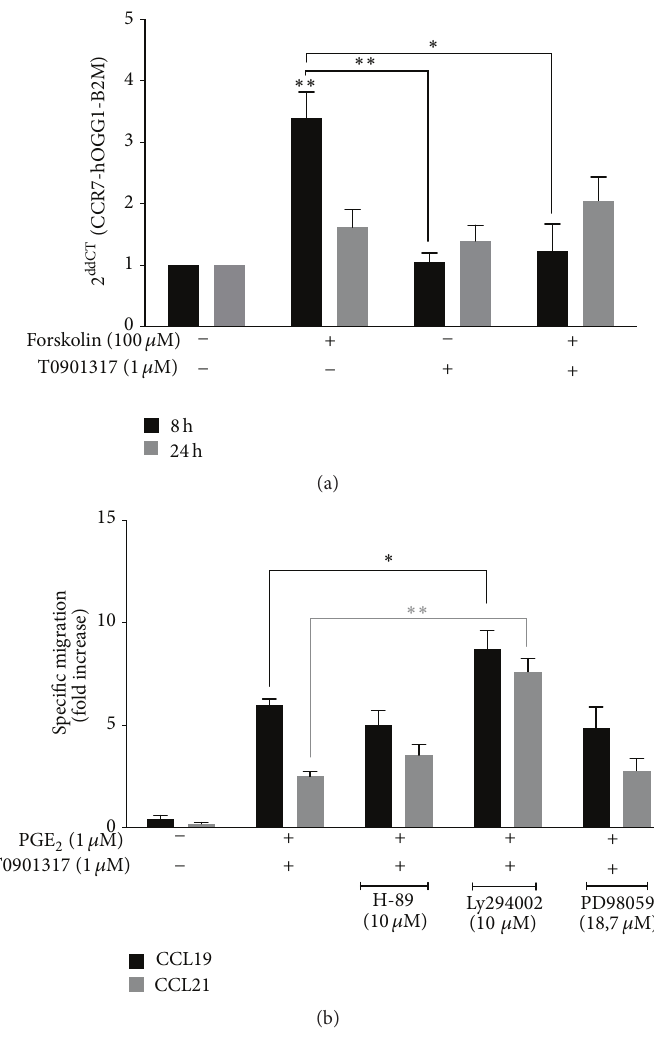
Figure 6: The role of cAMP and alternative EP 2 /EP 4 signaling pathways in PGE 2 - and T0901317-induced CCR7 mRNA expression and function. (a) MM-1 cells were treated for 8h (filled black) and 24 h (filled gray) with 100 𝜇 M forskolin alone or in combination with 1 𝜇 M T0901317. Total RNA was extracted and CCR7 transcripts were detected using real-time qPCR. (b) Chemotaxis assays in response to 300 ng/mL CCL19 (filled black) or CCL21 (filled gray) were performed in MM-1 cells treated with the indicated concentrations of H-89, Ly294002, and PD98059 before the addition of 1 𝜇 M PGE 2 and T0901317 for 48 h. The mean number of spontaneously migrating cells (that migrated to media alone) was subtracted from the number of cells that migrated in response to CCL19 or CCL21. Data represent mean ± SD of three independent experiments. ∗ 𝑝 < 0.05 , ∗∗ 𝑝 < 0.01